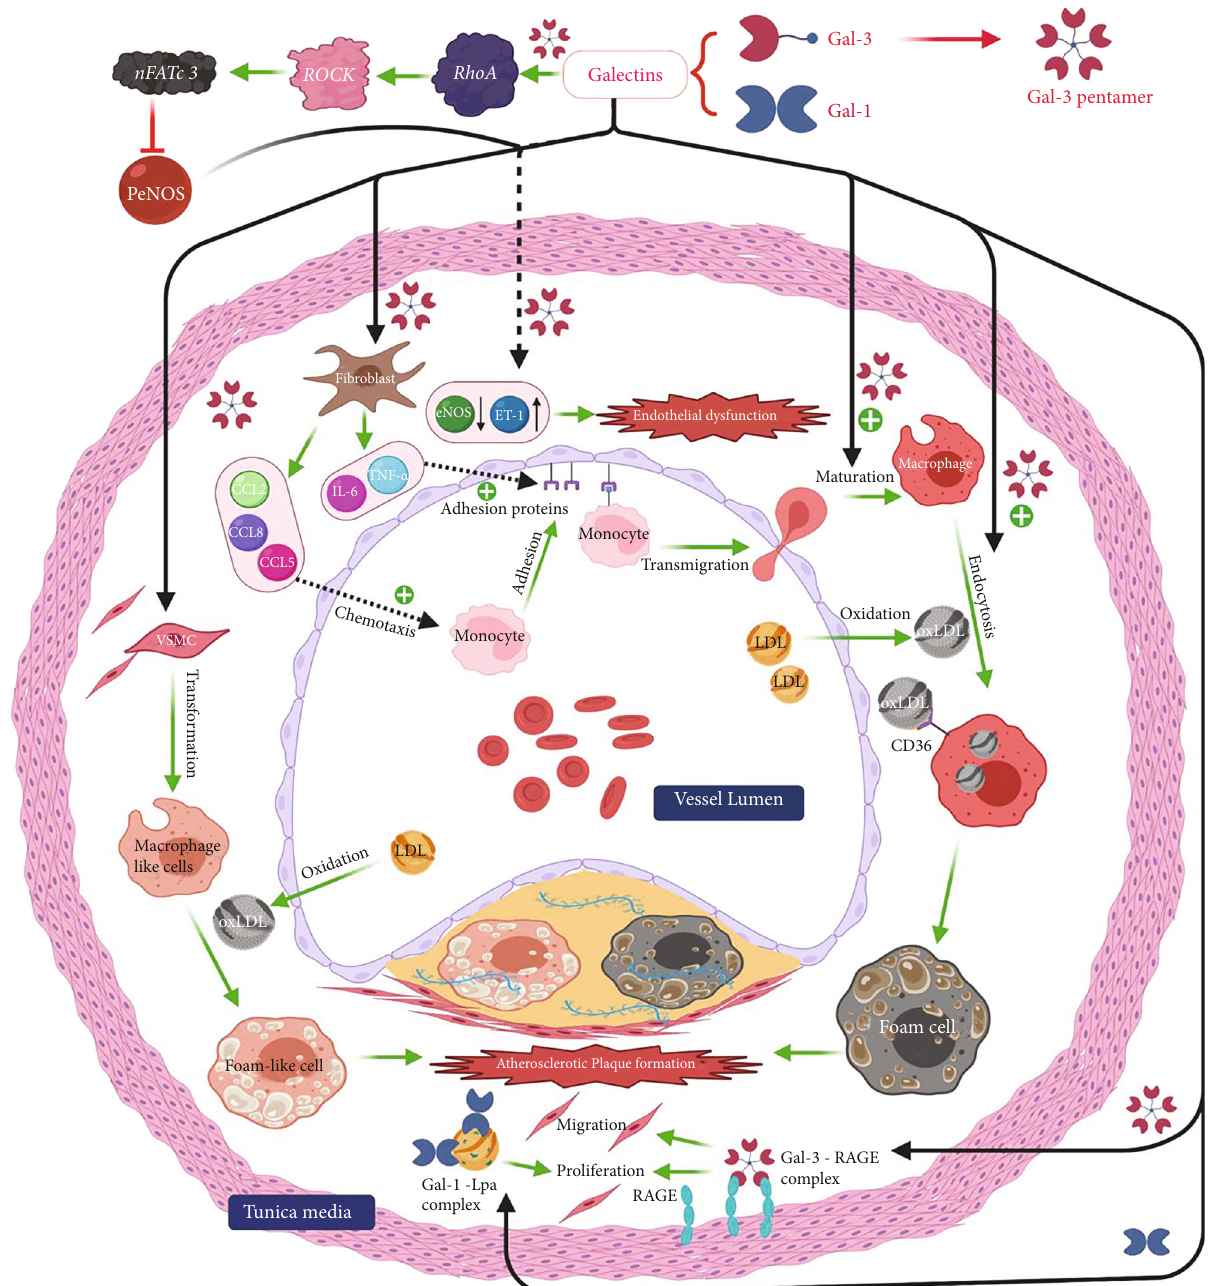
Figure 1: Demonstrates mechanisms and di ff erent pathways by which galectins can participate in the pathological process of atheromatous plaque formation as well as the induction of endothelial injury within blood vessels. RhoA: Ras homolog family member A; ROCK: Rho- associated protein kinase; nFATc3: nuclear factor of activated T-cells cytoplasmic 3; LDL: low-density lipoprotein; PeNOS: phospho- endothelial nitric oxide synthase; ET-1: endothelin 1; IL-6: interleukin 6; CD36: cluster of di ff erentiation 36; VSMC: vascular smooth muscle cells; ox-LDL: oxidized LDL; RAGE: receptor for advanced glycation end products; TNF: tumor necrosis factor; CCL 2/5/8: in fl ammatory chemokine ligands. This fi gure was created via BioRender